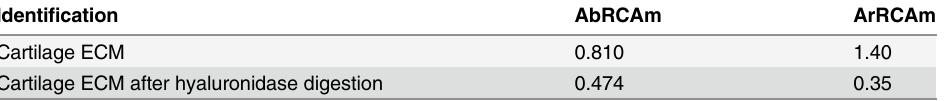
Table 1. Absorbance and area ratios obtained from FT- IR spectra of rat ear cartilage after hyaluroni- dase treatment. The spectra were normalized with respect to the amide I peak. Identi fi